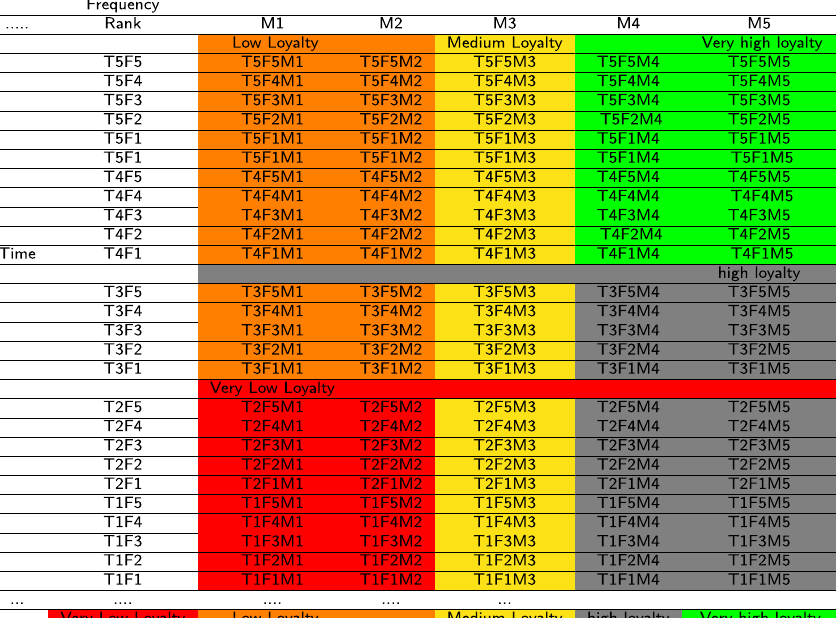
Table 9 Assessment criteria for TFM